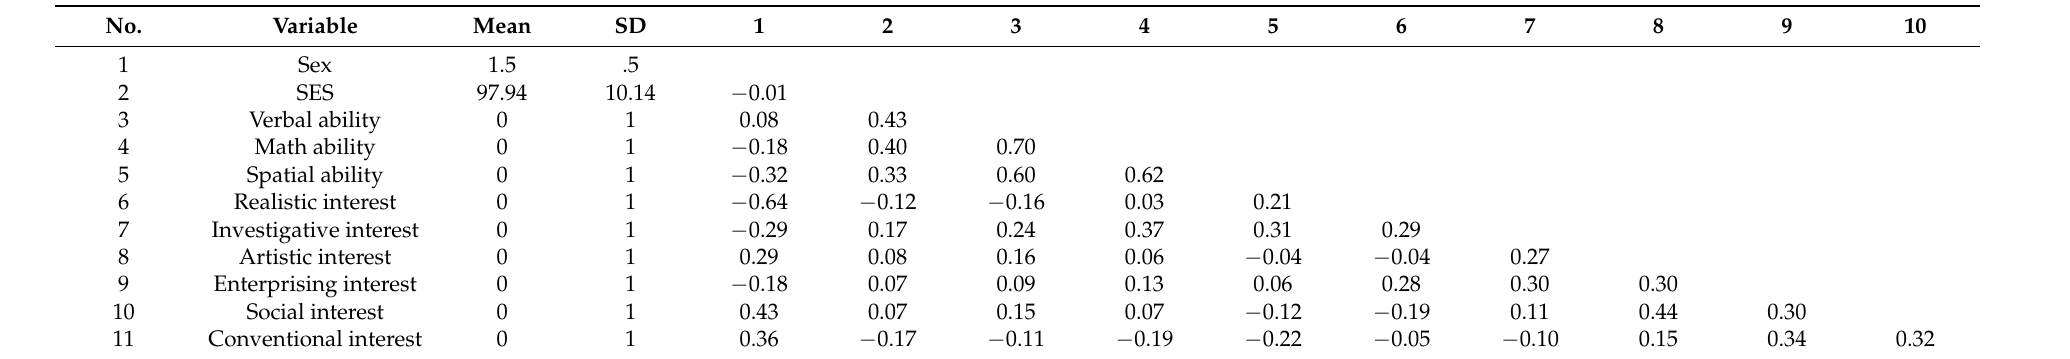
Table 1. Correlations among demographic variables, abilities, and interests.